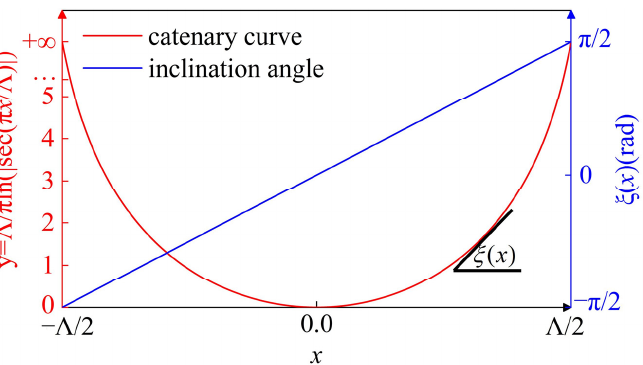
Figure 3. Catenary curve (red) and inclination angle (blue) distributions in a single catenary. The inclination angle between the curve tangent and the x axis, ξ ( x ) varies consecu- tively from − π /2 to π /2 between the left and right endpoints. According to the geometric phase relation, the catenary structure with continuous inclination angle variability can yield a linear geometric phase as follows: